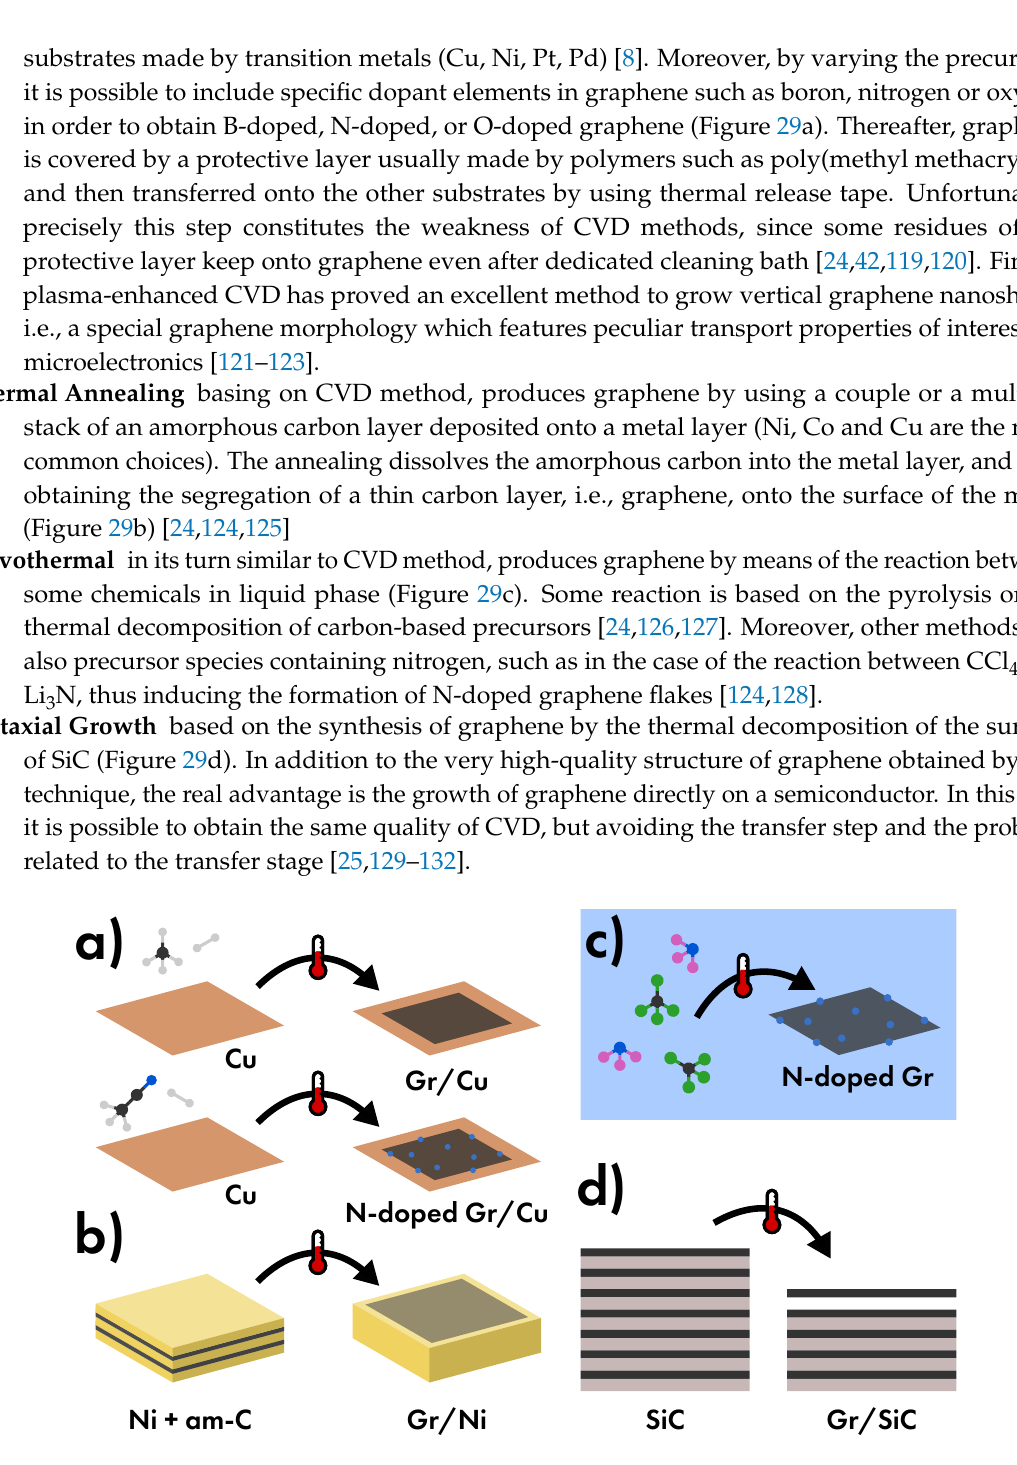
Figure 29. Representative depiction of graphene (Gr) or N-doped graphene (N-doped Gr) produced by ( a ) chemical vapor deposition, ( b ) thermal annealing of amorphous carbon (am-C) ( c ) solvothermal synthesis, and ( d ) epitaxial growth on